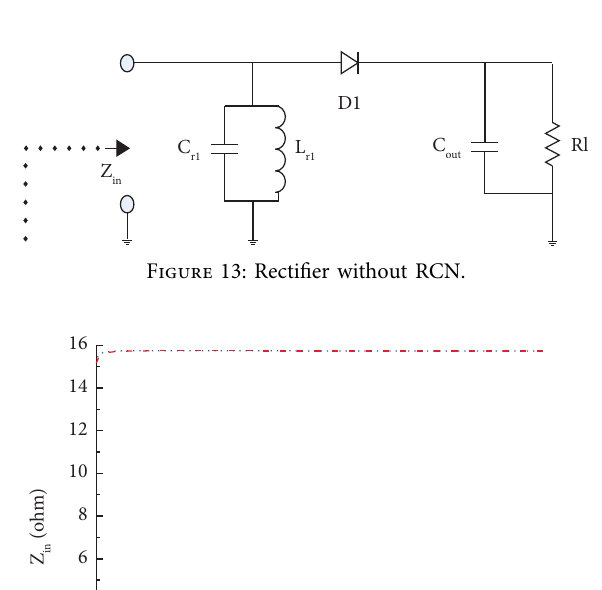
Figure 12: Two branch of RCN.